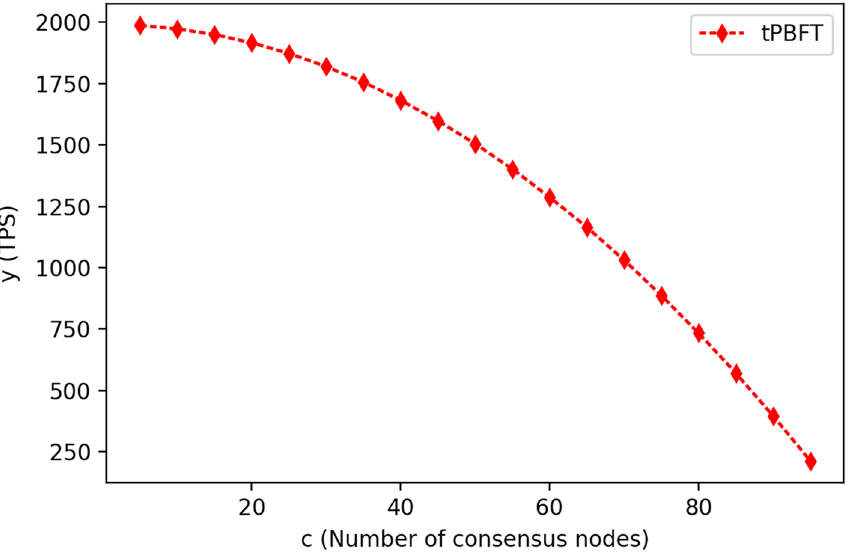
Figure 5. Graph of changes in consensus transaction volume per second when the number of consensus nodes